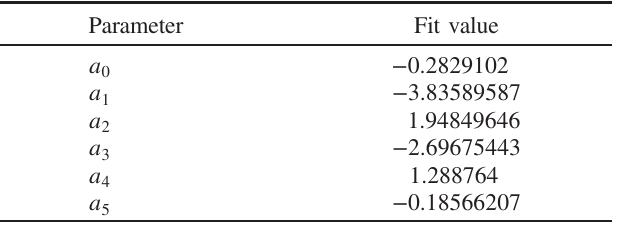
TABLE I. Parameters for the fifth order Enge function obtained from a fit to the magnetic profile of the MQXF